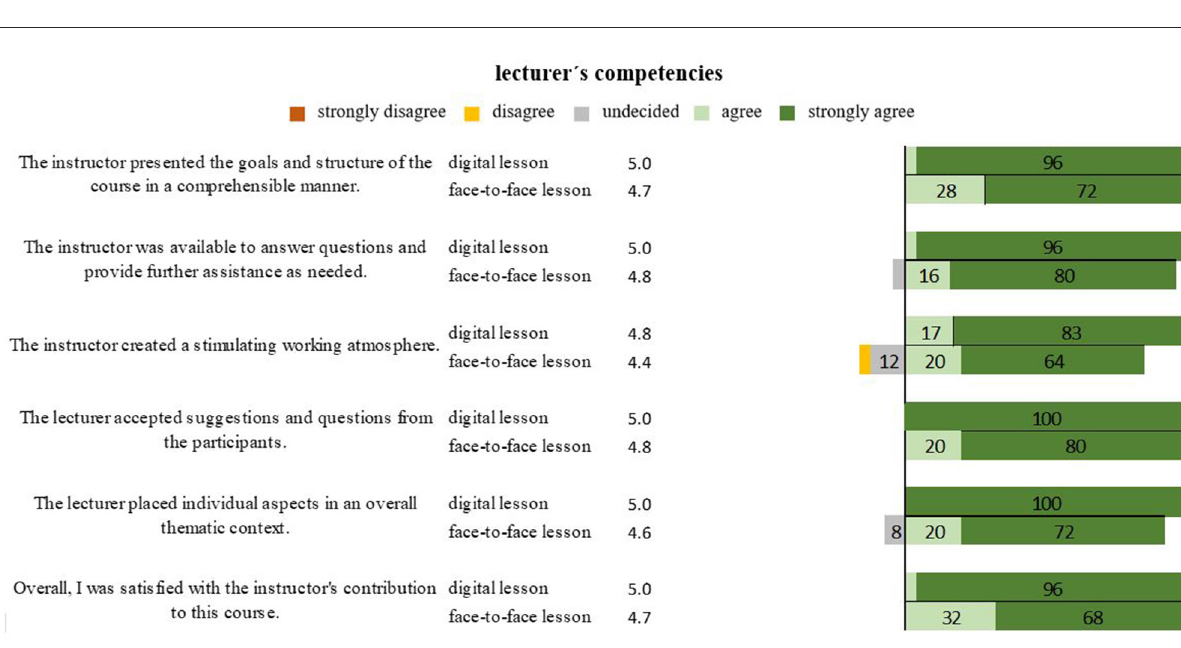
significantly better than 4.4 ( P = 0.013) for conventional teaching (Figure